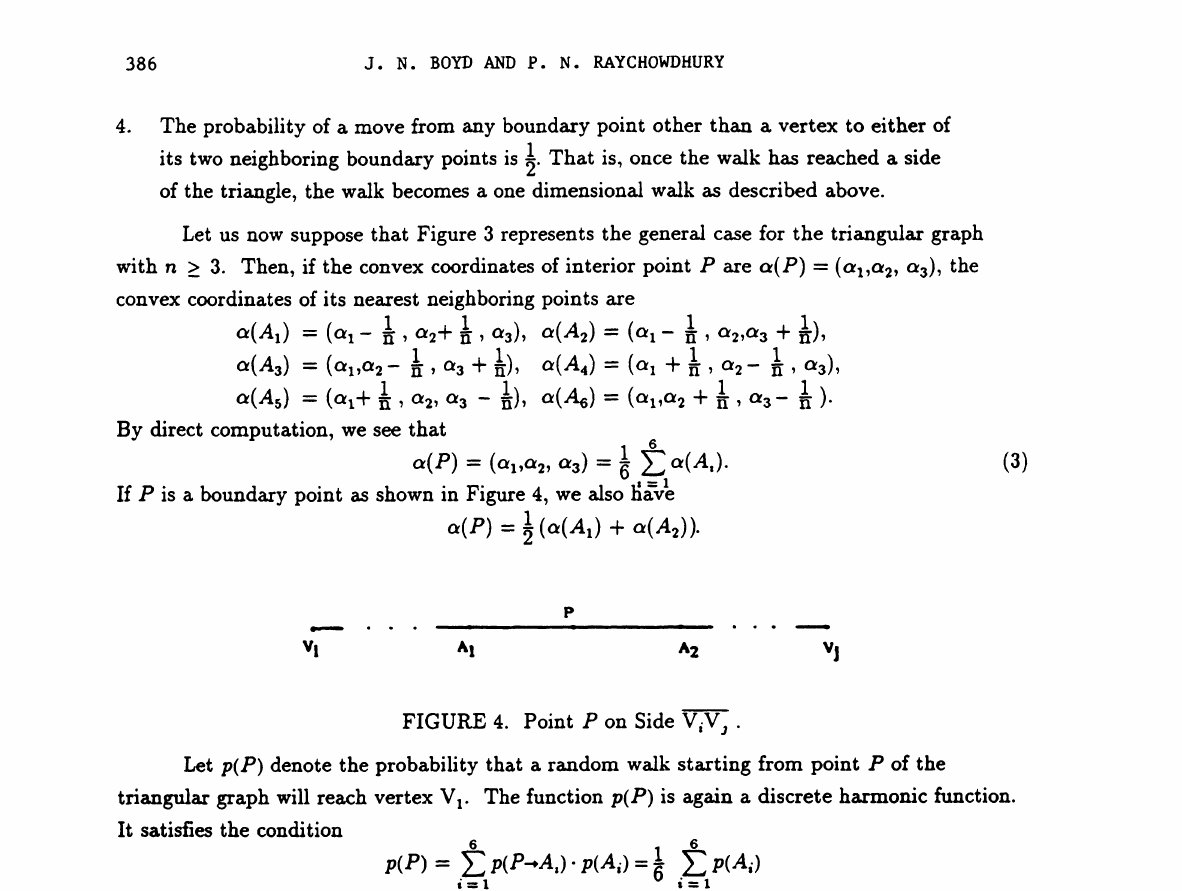
FIGURE 4. Point P on Side